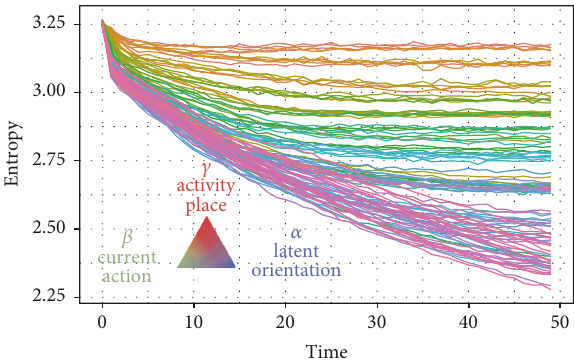
Figure 8: Evolution of entropy: colors in a RGB scale refer to parameter weights in decisions on actions in a next time-step, and their impact on entropy levels in different simulations (under the friction of distance). In the palette triangle, each color represents a specific combination of the three parameters. In each vertex, a parameter reaches maximum value while the others have minimum value. Results are averaged for 30 different runs for 125 parameter